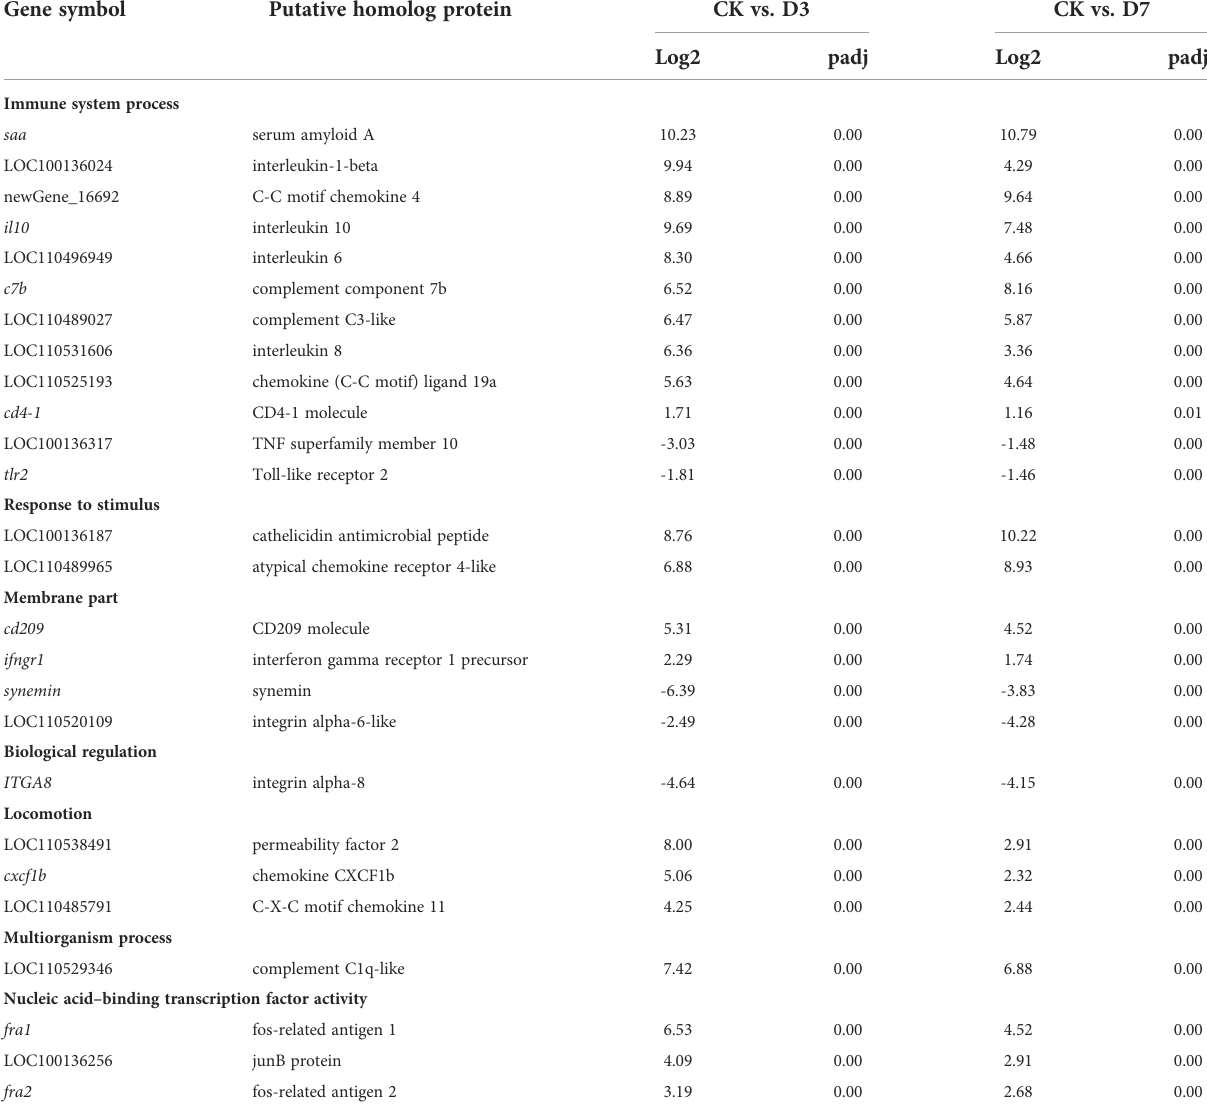
TABLE 4 Main DEGs annotated with immune-related GO terms. Gene symbol Putative homolog